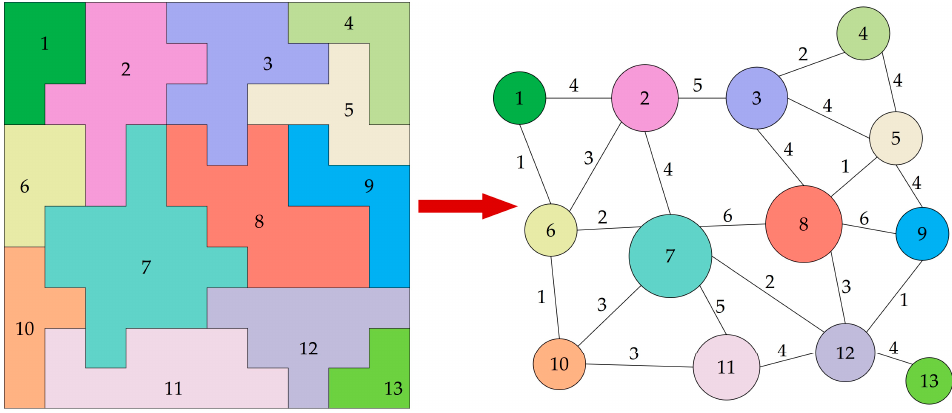
Figure 4. The RAG converted from the cluster map shown in Figure 3.